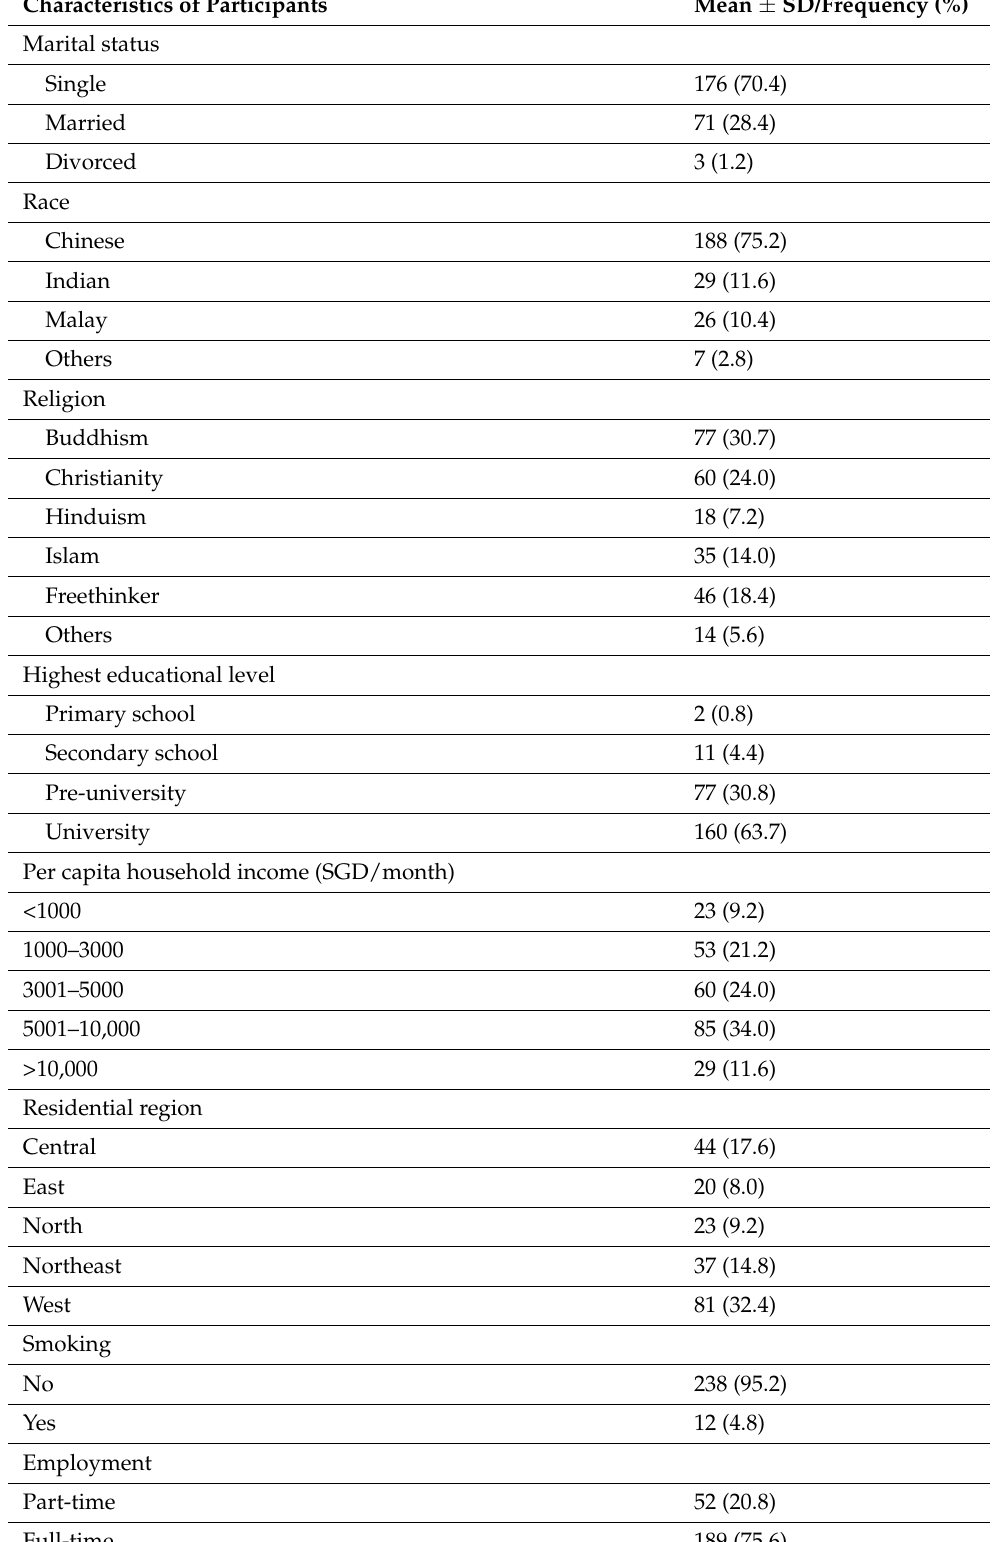
Characteristics of